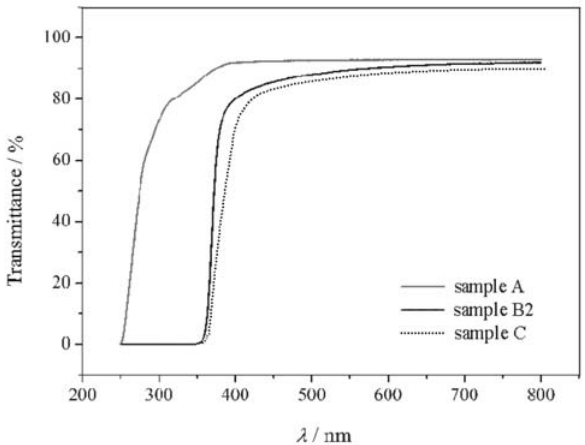
Figure 9. Light transmittance as a function of wavelength of pure PMMA (sample A), nanocomposite ZnO/PMMA (sample B2), sili- ca-coated ZnO/PMMA (sample